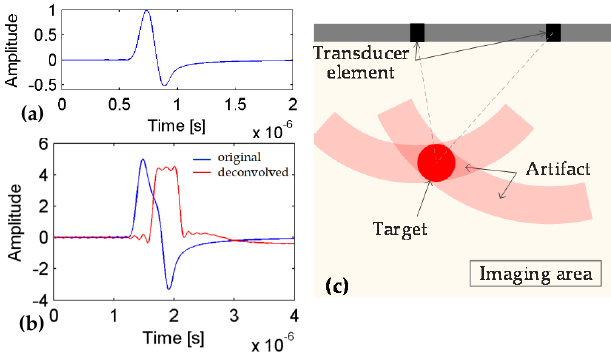
Figure 1. ( a ) Diagram of the normalized deconvolution kernel h ( n ) in simulation; ( b ) comparison of simulated signal before and after deconvolution; ( c ) illustration of the widespread artifacts forming process in delay-and-sum algorithm.